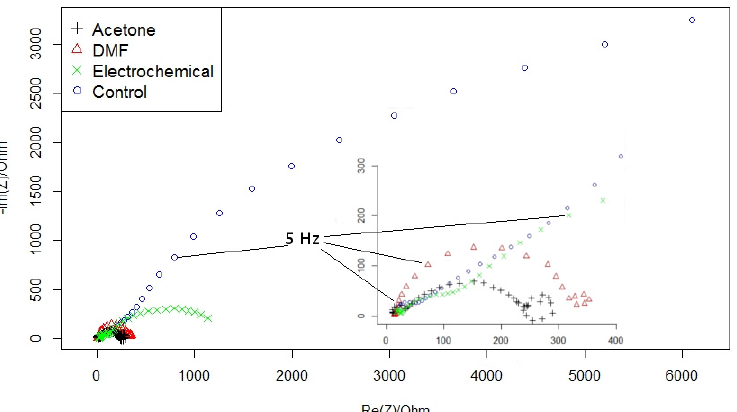
Figure 3. Nyquist plots from EIS experiments carried out at 0.250 V vs. Ag/AgCl (3.5M). The